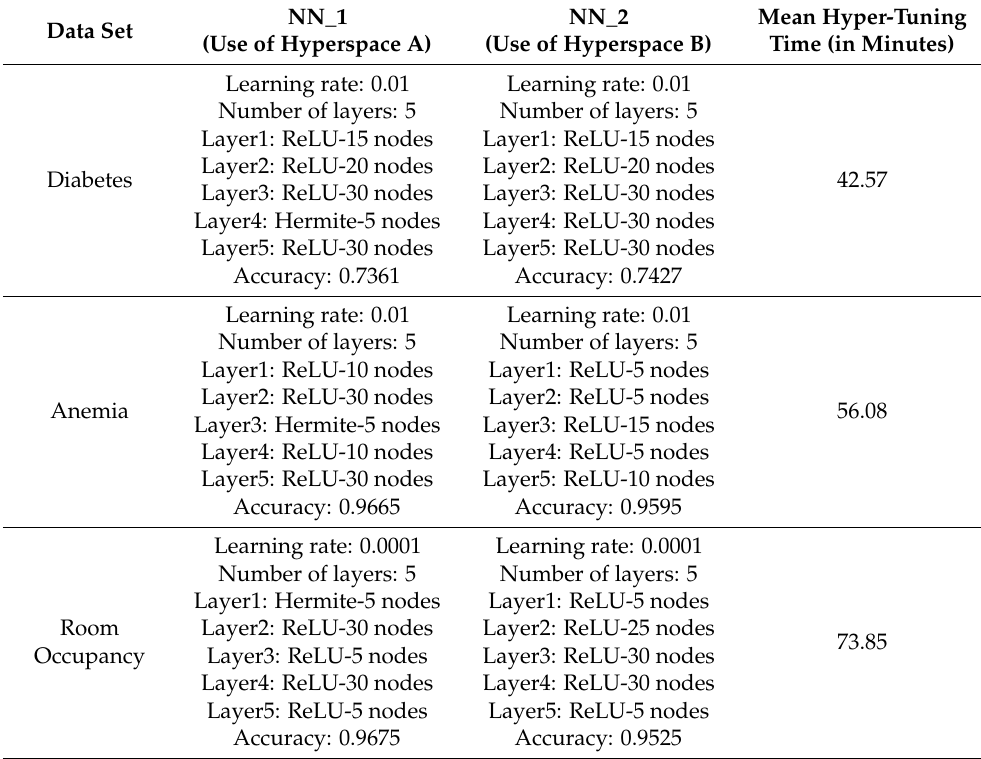
Table 8. (Second Experiment) Optimal hyperparameter values, classification (i.e., validation) ac- curacy evaluated on the testing data, and the mean time needed to perform the hyperparameter optimization (i.e., mean hyper-tuning time) obtained by the best neural network (NN_1) using the Hyperspace A, and the best neural network (NN_2), using Hyperspace B (Data sets: Diabetes, Anemia, Room Occupancy).